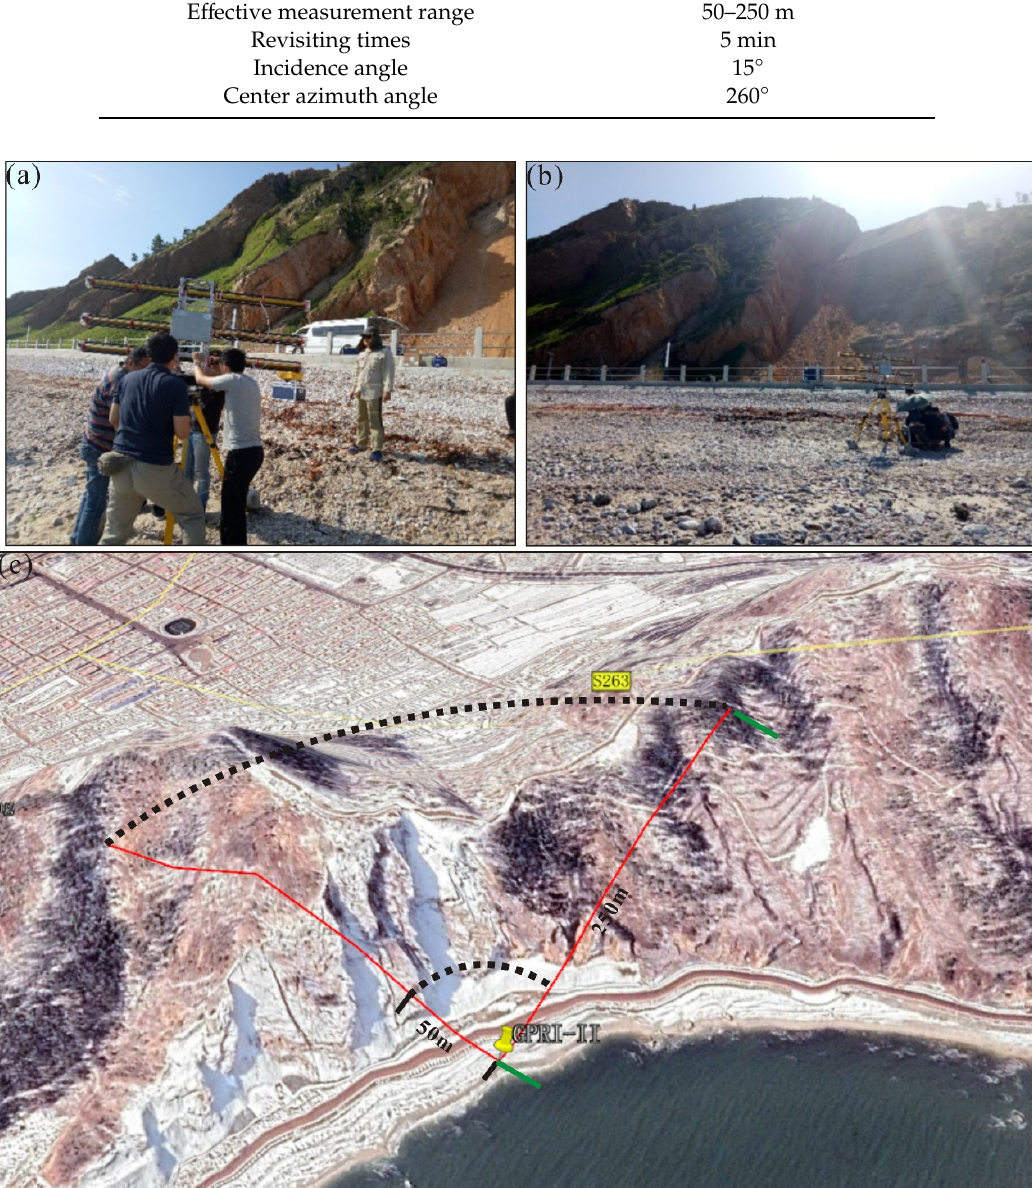
Figure 3. Equipment installation and data acquisition: ( a ) installation equipment; ( b ) data acquisition; ( c ) equipment location.